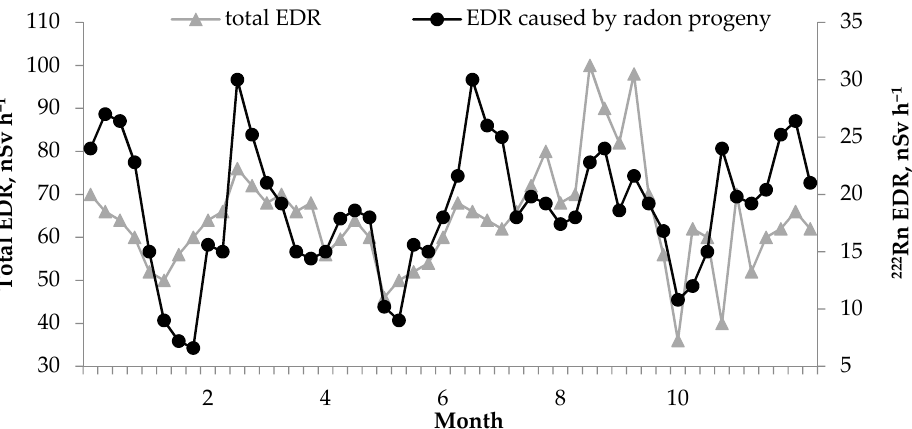
Figure 3. Variations of the equivalent dose rate caused by 222 Rn and total equivalent dose rate in the underground parking lots.